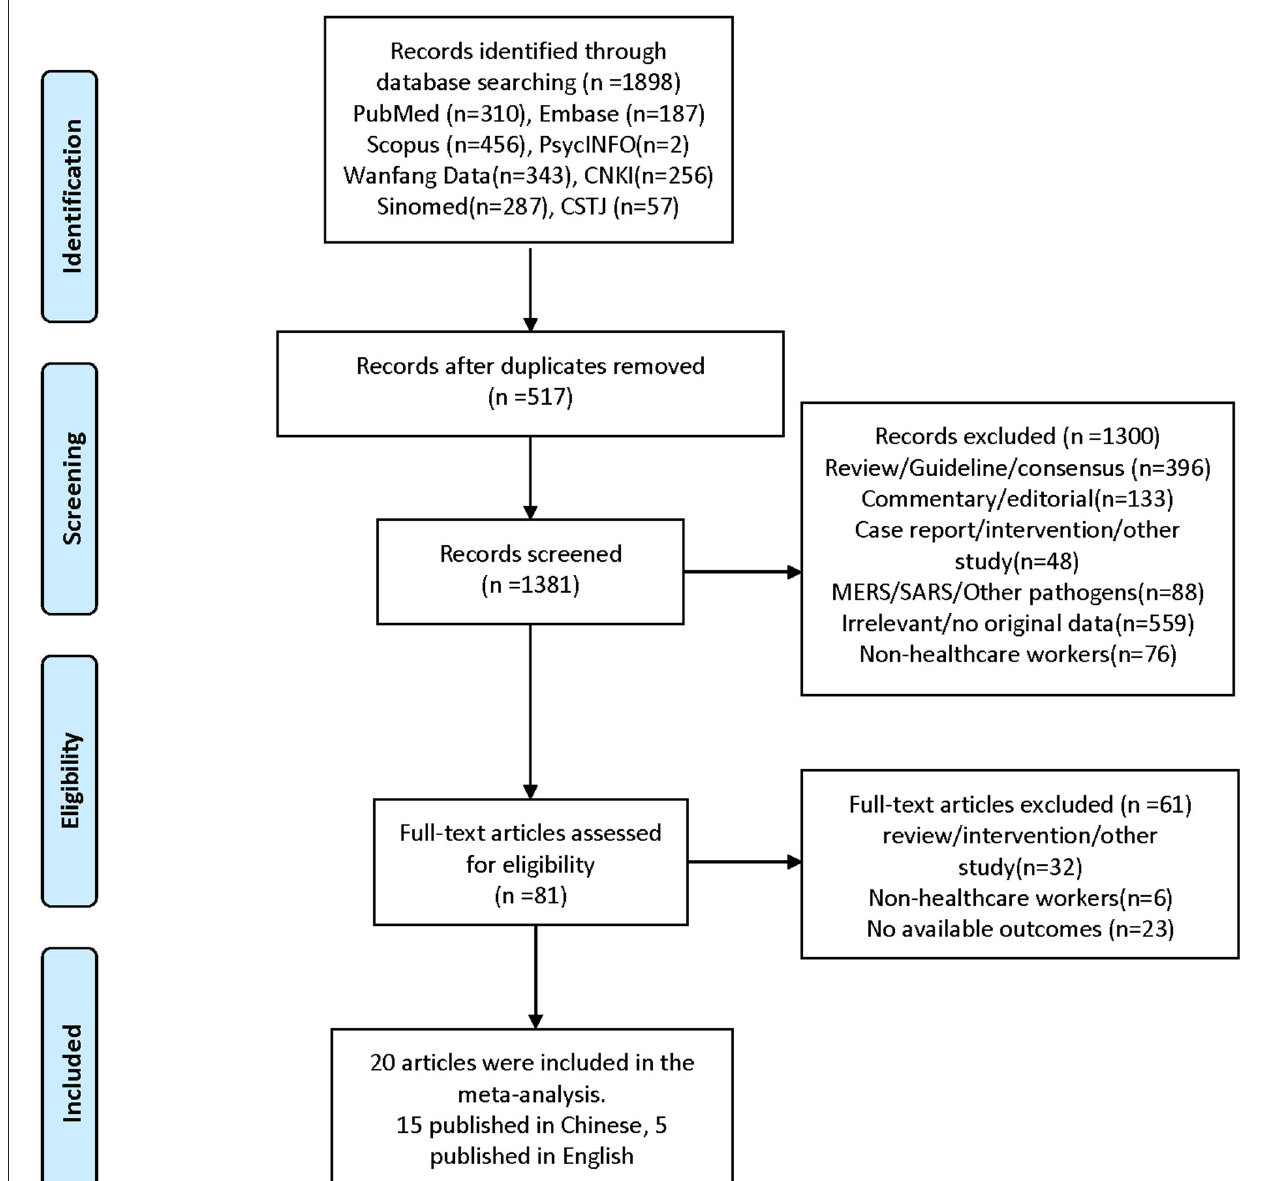
FIGURE 1 | Preferred reporting items for systematic reviews and meta-analyses flow diagram of included studies